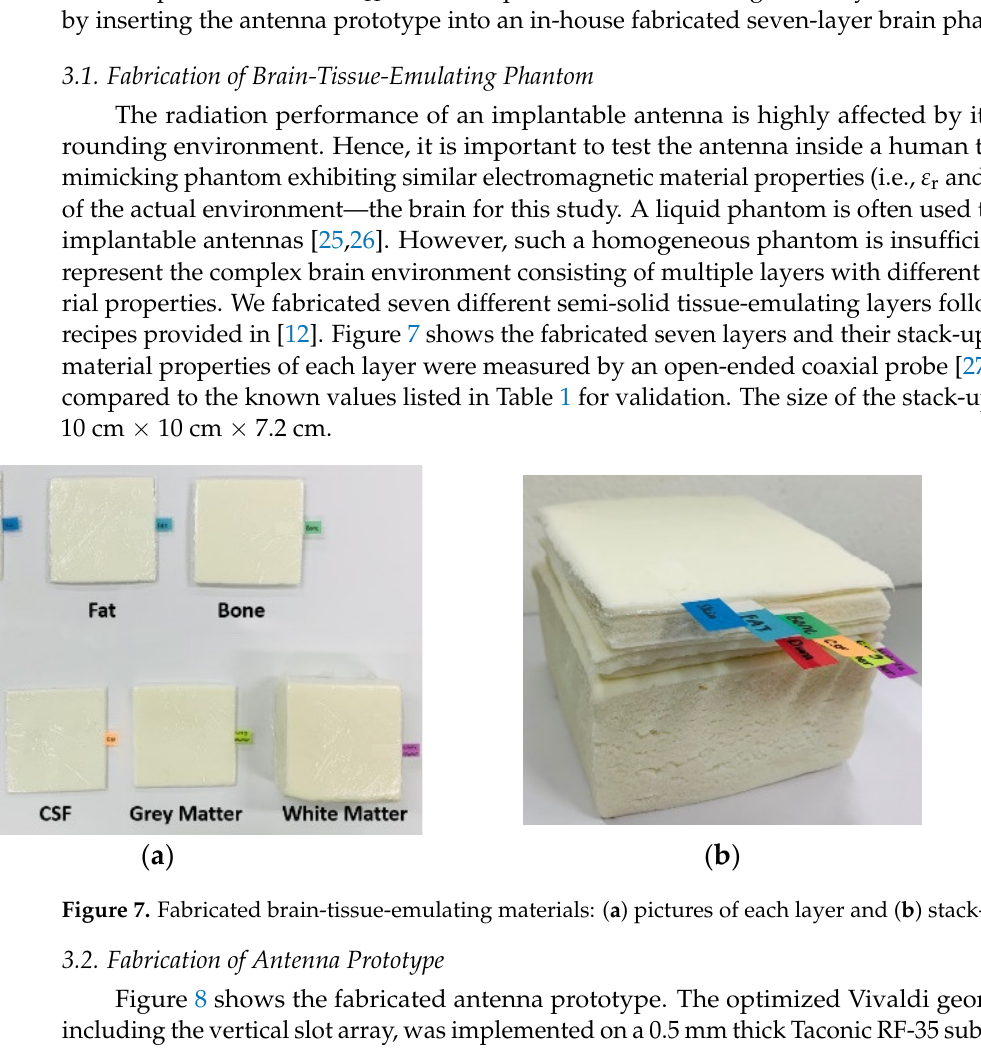
Table 2. Optimized antenna parameters.